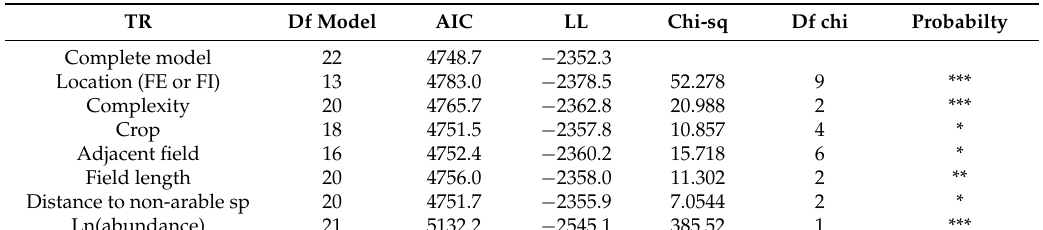
Table 8. The best fitting model for TR (Model 1000, Table 3; model estimates in Table S5 b). Variables included Location (FE or FI), Complexity at 1000 m, crop in the FI (soybean or corn), closest adjacent field (soybean, corn, grassland or developed), length of the FE (m), distance to nearest non-arable (green) space > 1 ha, and sample size (ln abundance). The importance of the separate fixed factors were tested with a LRT. Df: degrees of freedom; AIC: Akaike information criterion, LL: Log Likelihood: Chi-sq: Chi-square (* p < 0.05; ** p < 0.01; *** p < 0.001).